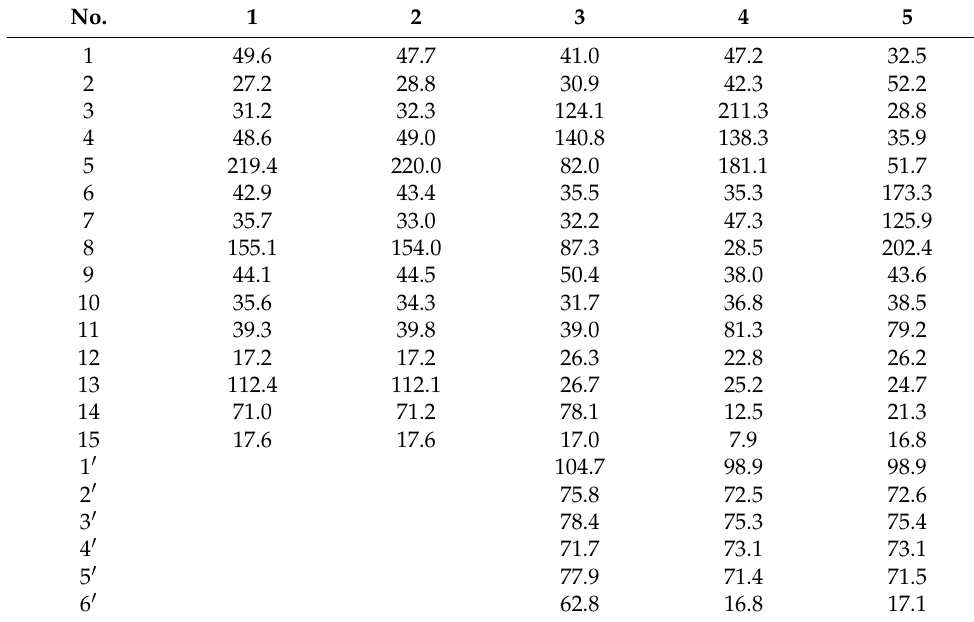
Table 2. 13 C NMR data of compounds 1 – 5 in CD 3 OD ( δ in ppm).